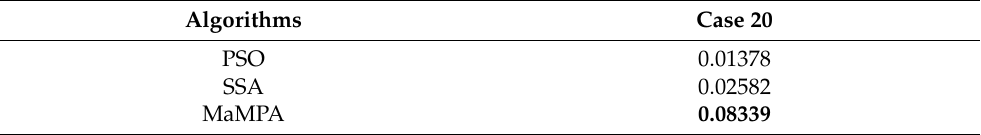
Table 16. Hypervolume comparison of MaOPF problems in the IEEE 118-bus